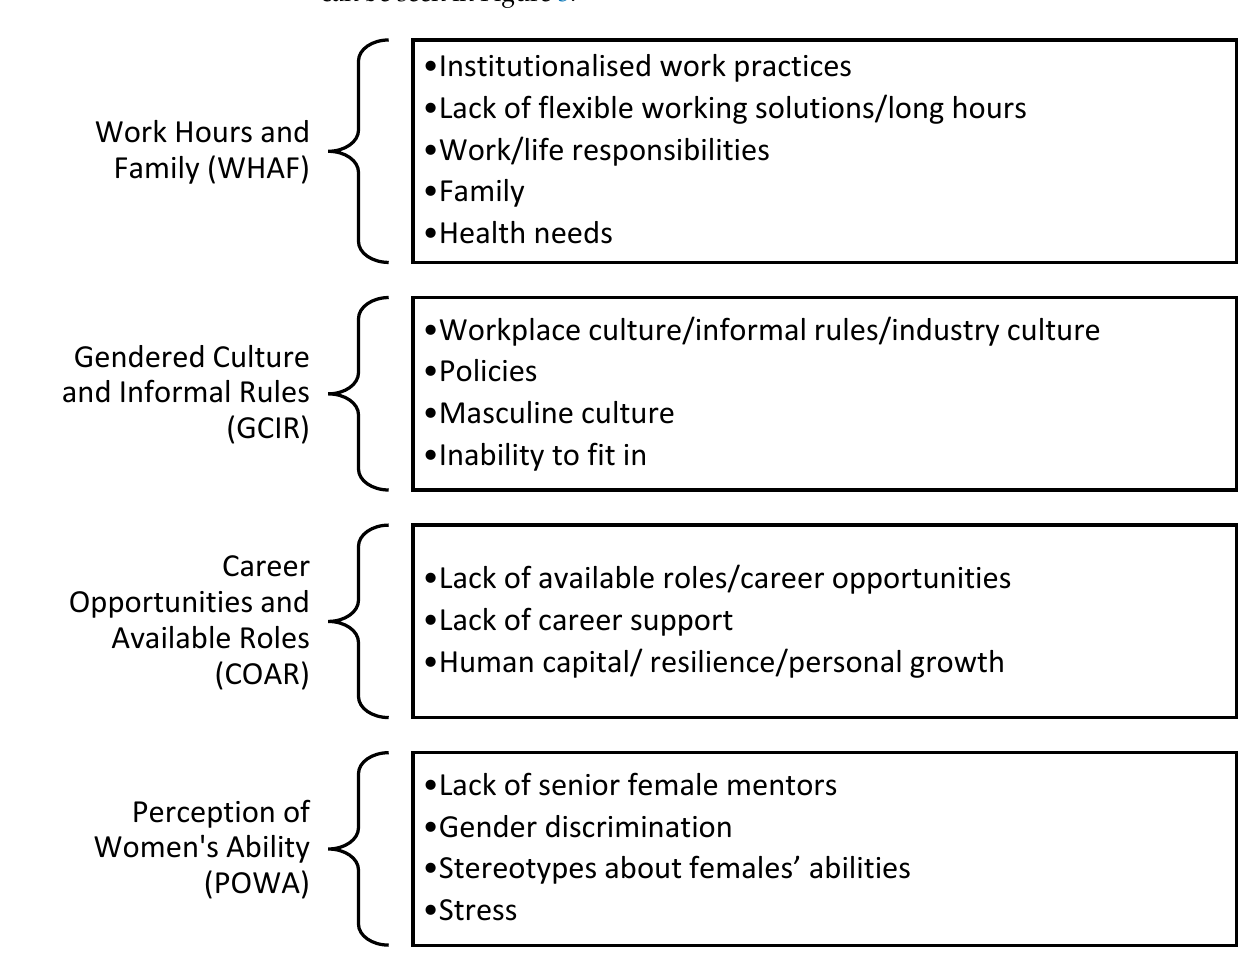
Figure 3. The four themes identified in the focus group.